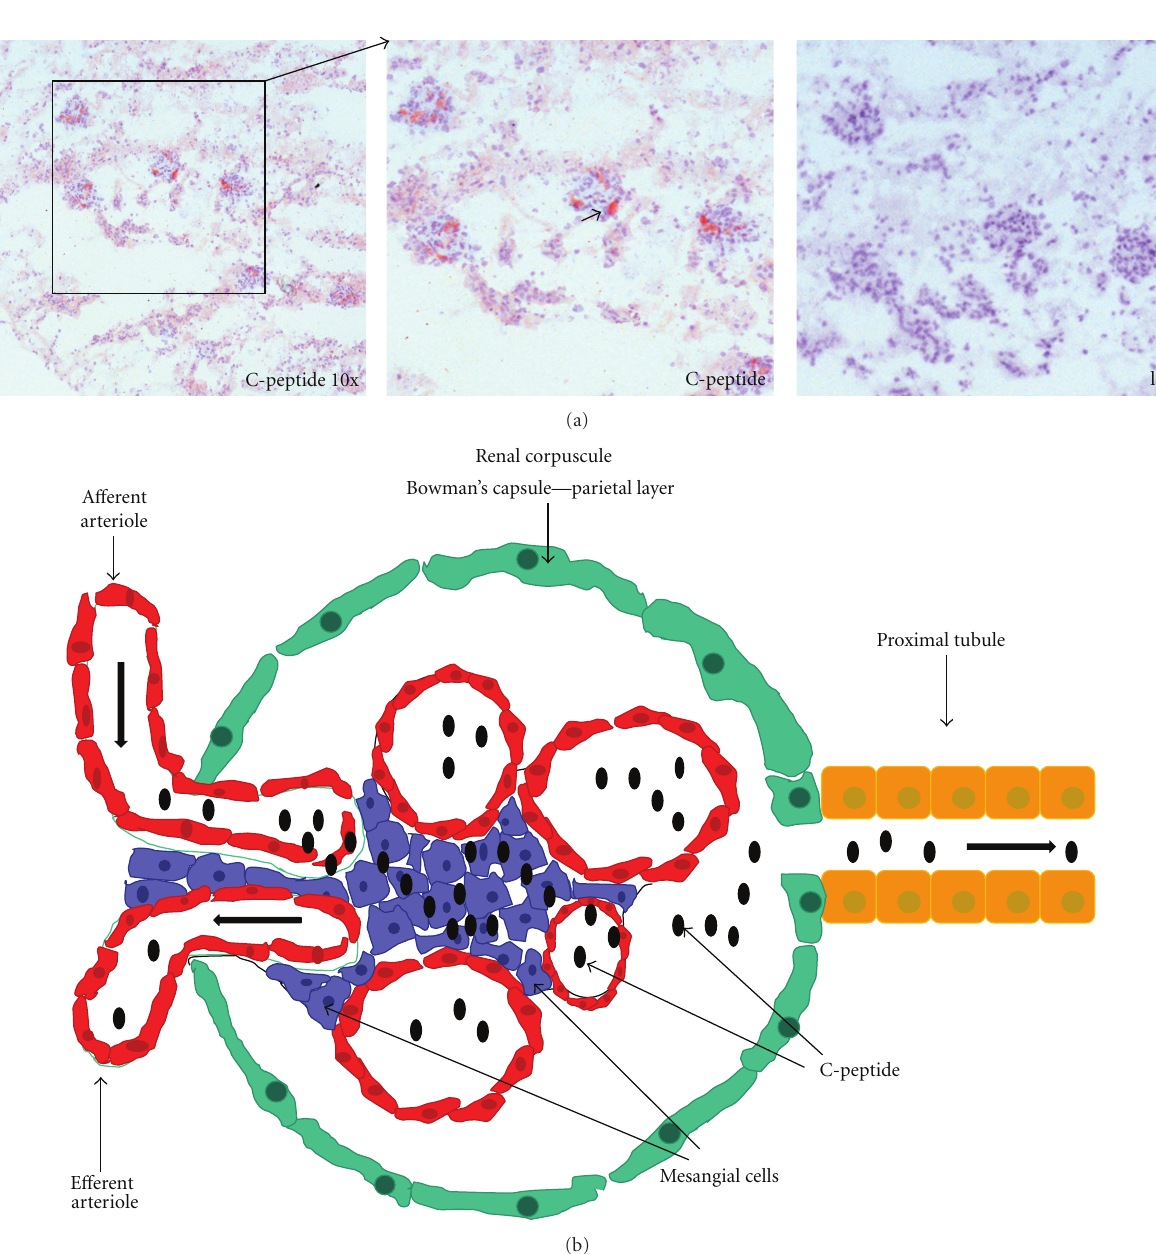
Figure 2: C-peptide deposition in mouse juxtaglomerular apparatus. Upper panel: Representative photograph of mouse kidney sections with C-peptide deposition in the glomeruli in C-peptide treated mice (Figure 2(a)). Red areas represented C-peptide deposition indicated by arrow. On the lower panel is schematic explained the way C-peptide induces proliferation of mesangial cells suggesting a possible role of C-peptide in glomerular hyperproliferation in patients with diabetic nephropathy (Figure 2(b)). C-peptide levels are connected with increased